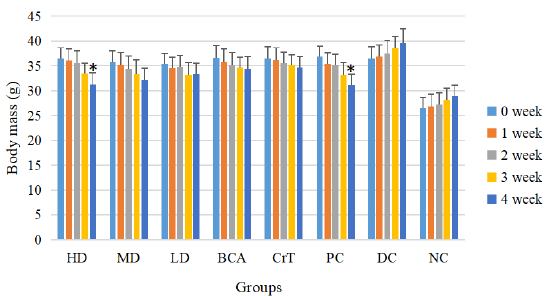
Figure 6. Comparison of body mass changes. Values are means ± SD ( n = 7). There were significant differences in body weight before and after the experiment (denoted by “*” for p < 0.05).